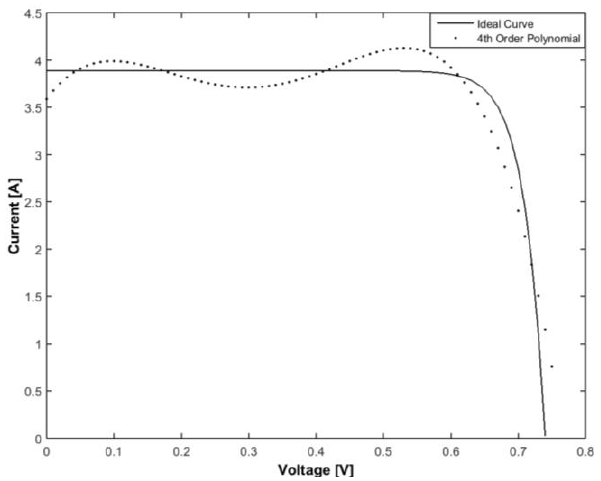
Figure 10 . I-V curve with 4th order polynomial fitting. If we look at the figure, we can see that there are differences between the two curves. The curve obtained by ideal value looks smoother than the curve obtained by polynomial fitting. The curve obtained by polynomial fitting method has deviations in the curve as the fitting occurs. The obtained I-V curve from measured data by using 4th order polynomial is presented in figure 11.